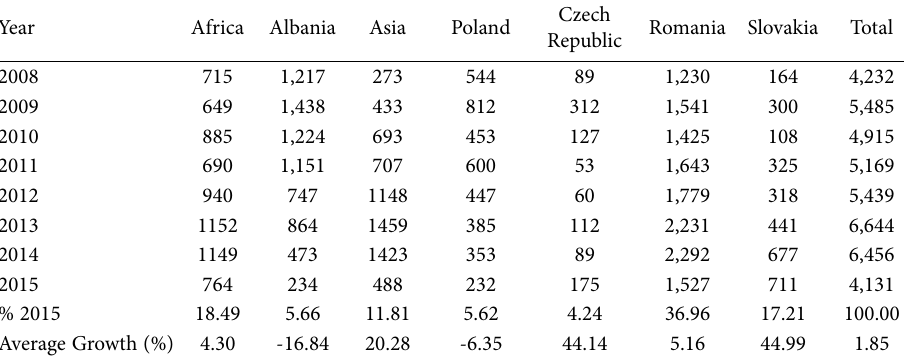
Table 3. Nationality of major groups of immigrants per year and average variation